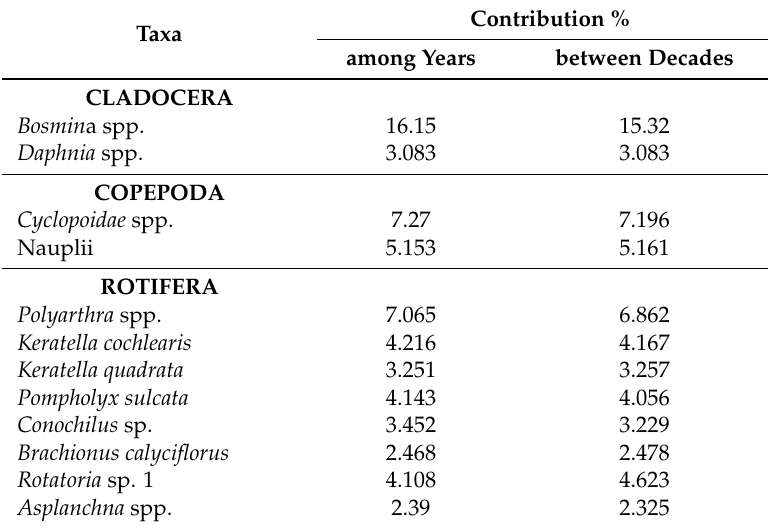
Figure 3. Temporal trend of small (<10 cm) ( a ) and large (>25 cm) ( b ) fish in the Lake Søbygaard region during the 23 years of study (1990–2012). Table 1. Zooplankton species account for 70% of the taxa difference across years and between the first (1990–2000) and second decade (2001–2012) in Lake Søbygaard. Results of PERMANOVA analysis (p < 0.0001 in both cases).